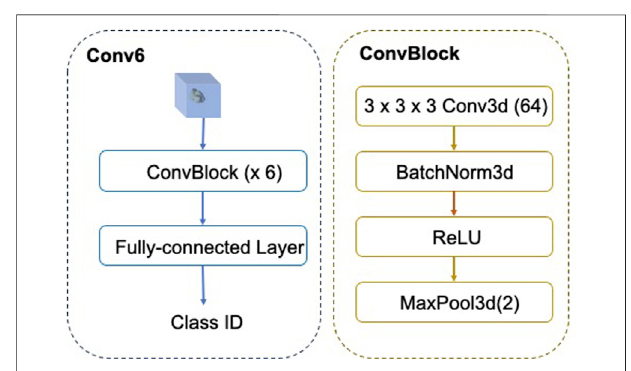
FIGURE 5 | Architecture of FSCC Conv-6. In Conv-6, the feature extractor f θ comprises six ConvBlocks and the classi fi er is the fully connected